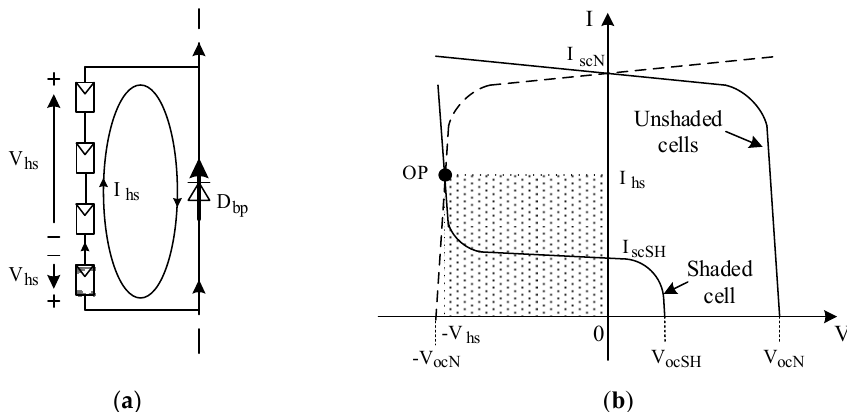
Figure 5. Illustration of the hot spot formation: equivalent circuit ( a ); location of the operating point (OP) of the shaded cell ( b ). The shaded area represents the power dissipated at the hot spot.